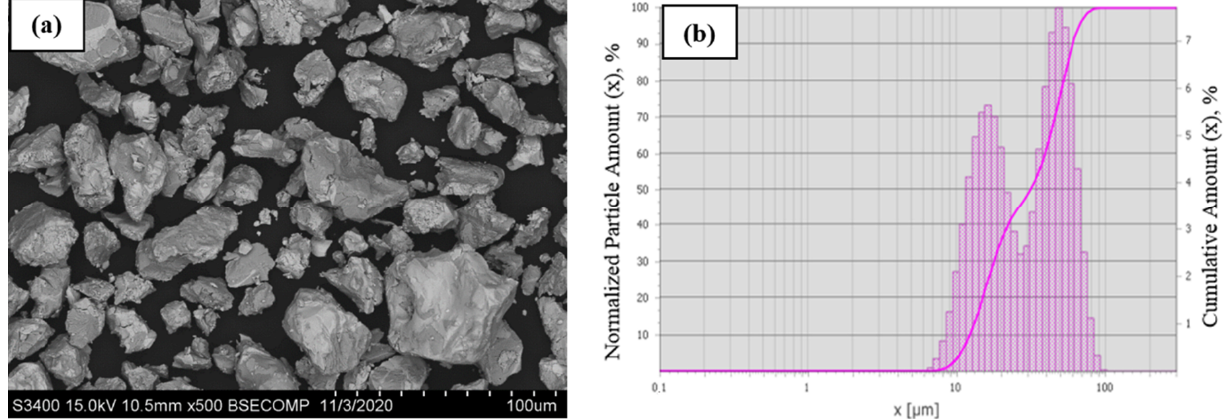
Figure 19. The morphology of the comminuted particles ( a ) and the granulometric composition ( b ) of the NiAl–Cr– Co+15%Mo alloy.